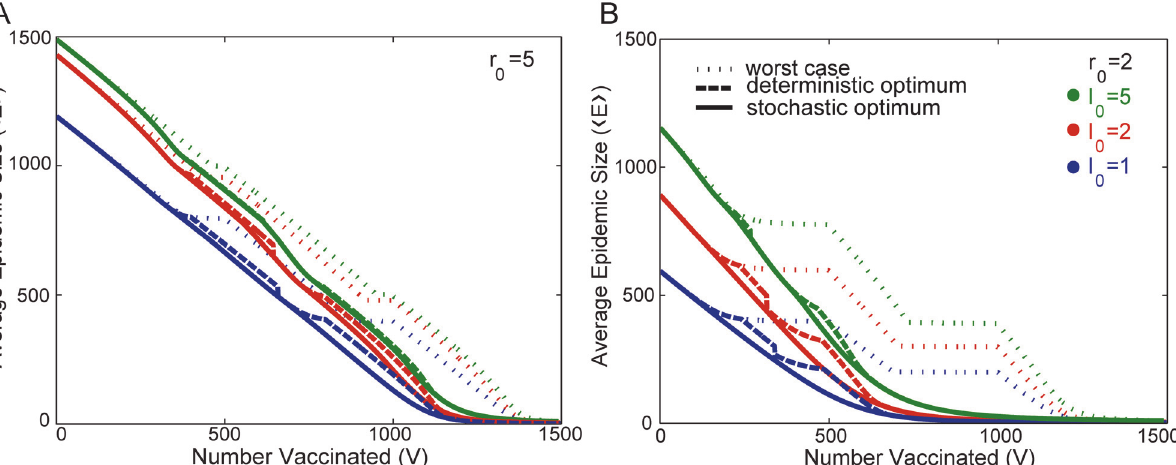
Fig 7. Comparison of Average Epidemic Size for Optimal, Deterministic Optimal, and Worst Case solutions. These figures illustrate the average epidemic size h E i for three different protocols: the stochastic optimum (minimizes h E i ), the deterministic optimum, and the worst case scenario (maximizes N 1 = 500 h E i ). The three different colors correspond to different number of initial infected individuals I 0 . Results are obtained for two populations with size individuals and N 2 = 1000 individuals. Results are shown for r 0 = 5 in Figure A, and r 0 = 2 in Figure B. Other than the value of r 0 , the color and line style legends in Figure B apply to both